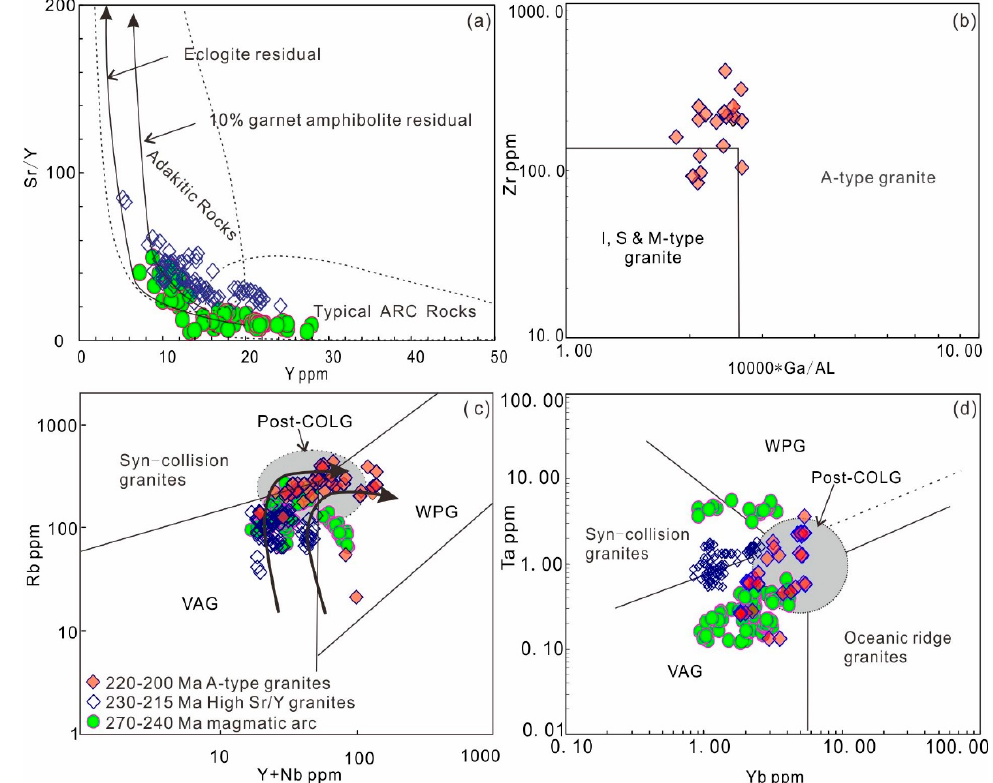
Figure 12. Tectonic discrimination diagrams for the Late Paleozoic–Triassic granitoids. ( a ) Y vs. Sr/Y (Defant et al. [132,133]), ( b ) 1000 ∗ Ga/Al vs. Zr (Whalen et al. [134]), ( c ) Y + Nb vs. Rb (Pearce et al. [135]), and ( d ) Yb vs. Ta diagrams (Pearce et al. [135]). VAG—volcanic arc granite, WPG—within plate granite, COLG—collisional